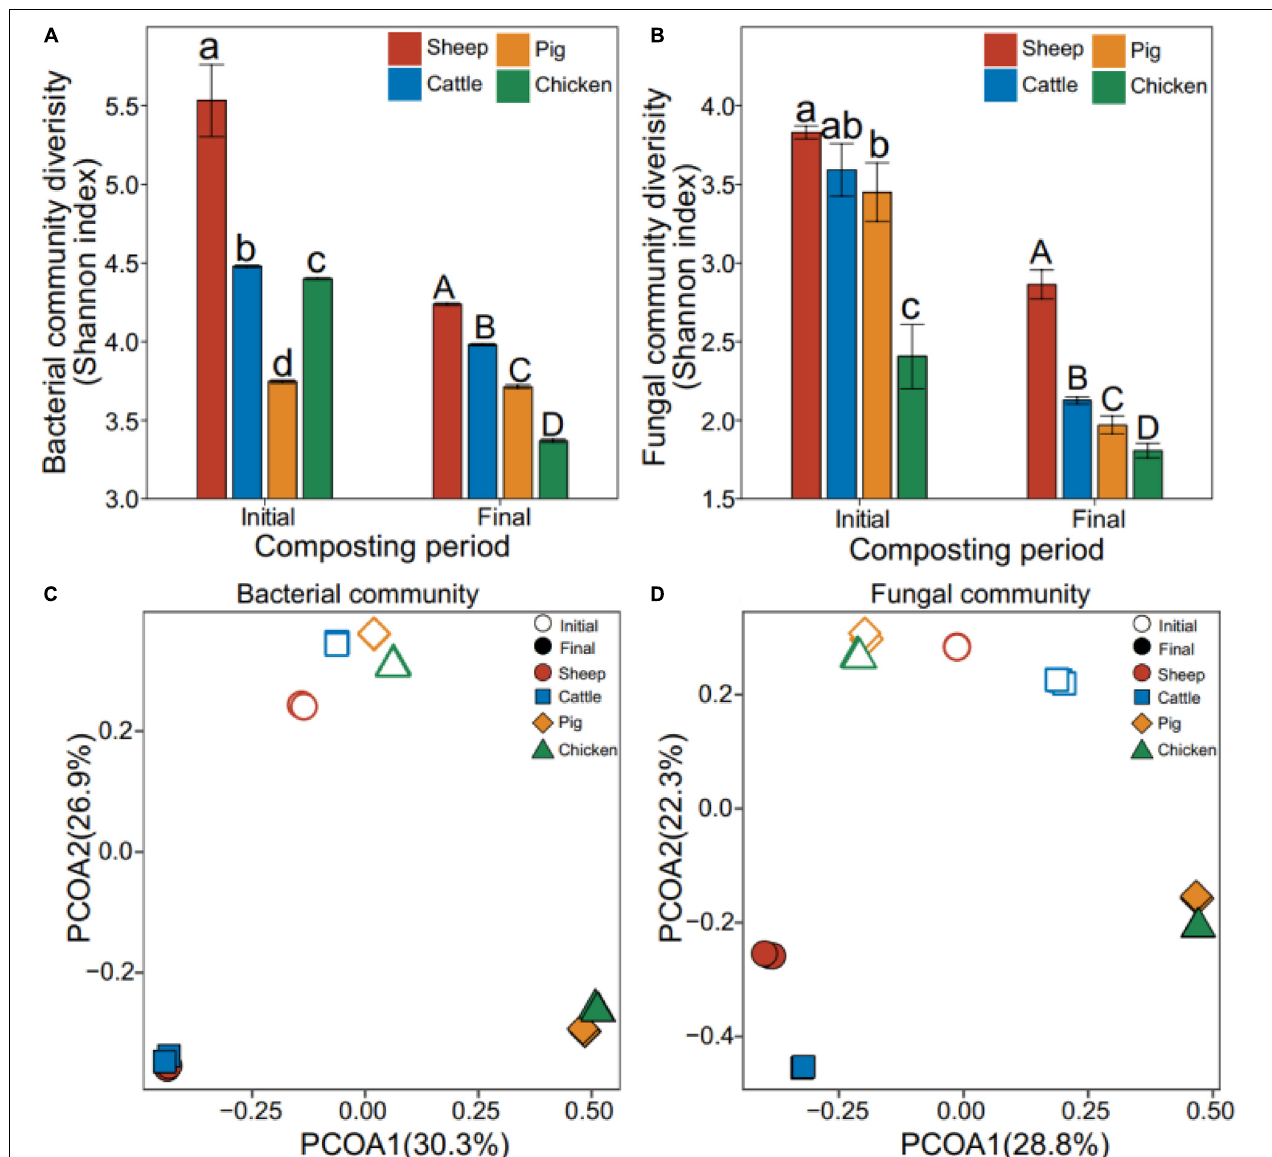
FIGURE 2 | Effect of composting on manure compost metataxonomy diversity and composition. Shannon diversity of bacterial (A) and fungal (B) communities. Bacterial (C) and fungal (D) community composition based on the principal coordinate analysis of unweighted UniFrac distance matrix. Colors correspond to different types of manure composts, and open and closed symbols represented initial and final phases of composting, respectively. N = 3 for each type of manure